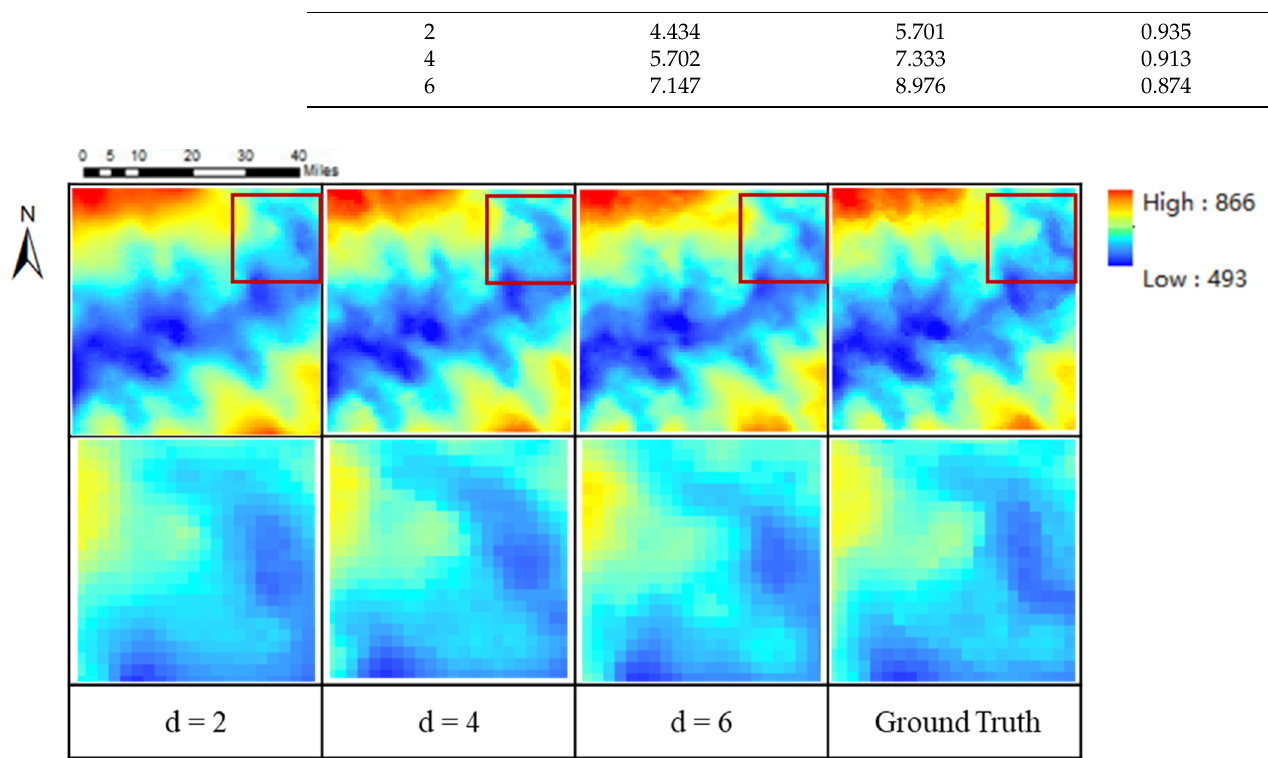
Figure 18. DEM SR results for different down sampling factors (The details in the red box are in the next row).